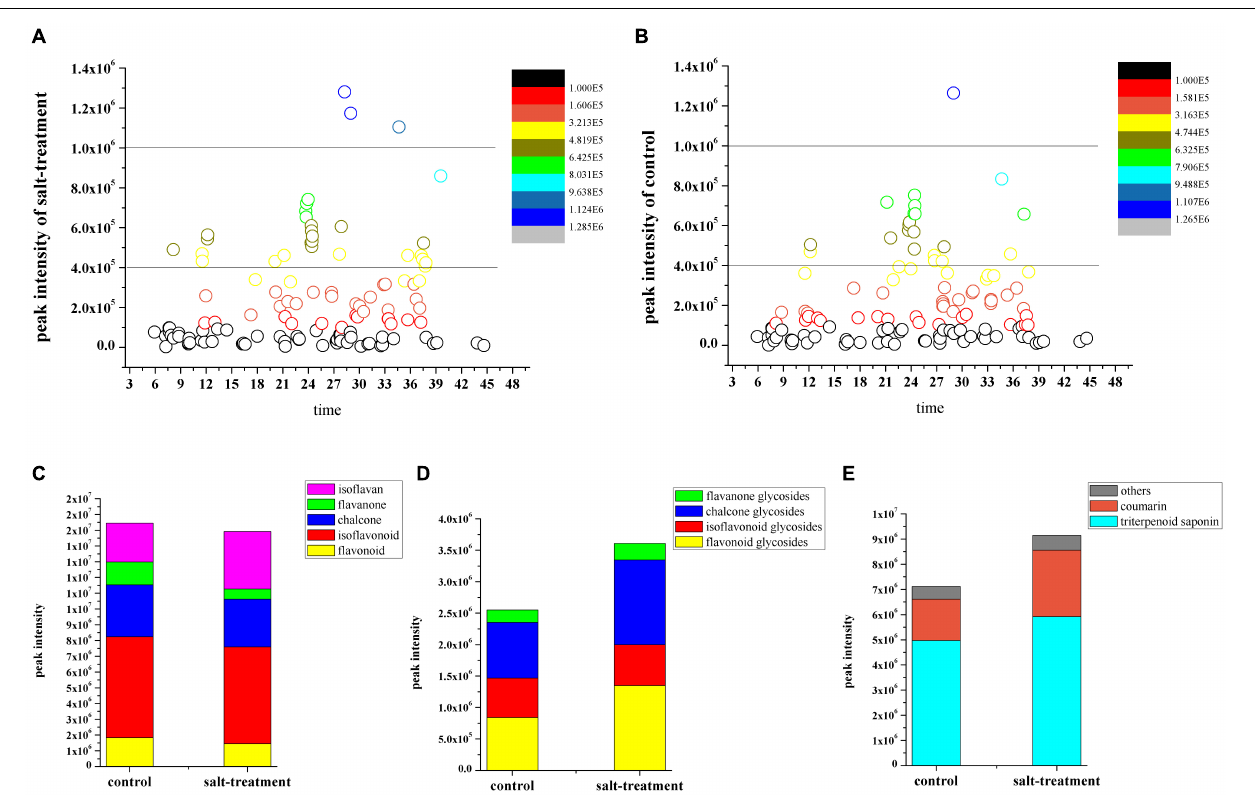
FIGURE 1 | Distribution of bioactive constituents identified using ultrafast liquid chromatography (UFLC)-triple time-of-flight tandem mass spectrometry in (A) salt-stressed group and (B) control group based on their retention time. Total content changes in (C) flavonoid, (D) flavonoid glycoside, (E) triterpenoid saponin, coumarin, and other constituents between two groups.